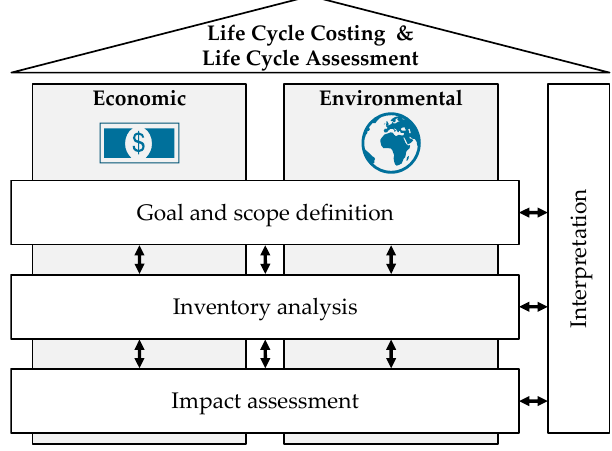
Figure 2. Methodology of life cycle assessment and life cycle costing.